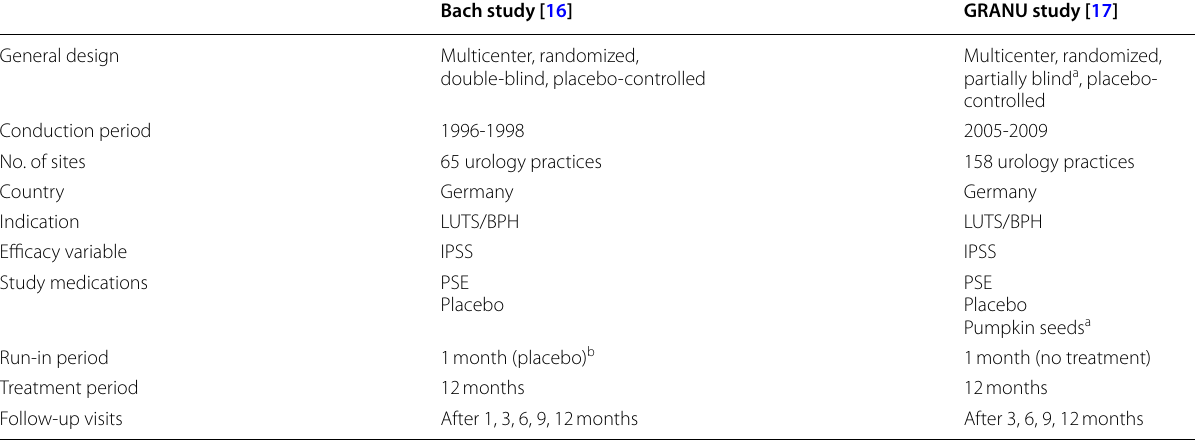
PSE pumpkin seed soft extract a Open administration of Uromedic ® pumpkin seeds; data ignored for the meta-analysis b Patients with change in IPSS 3 points during the run-in period were excluded from ≥